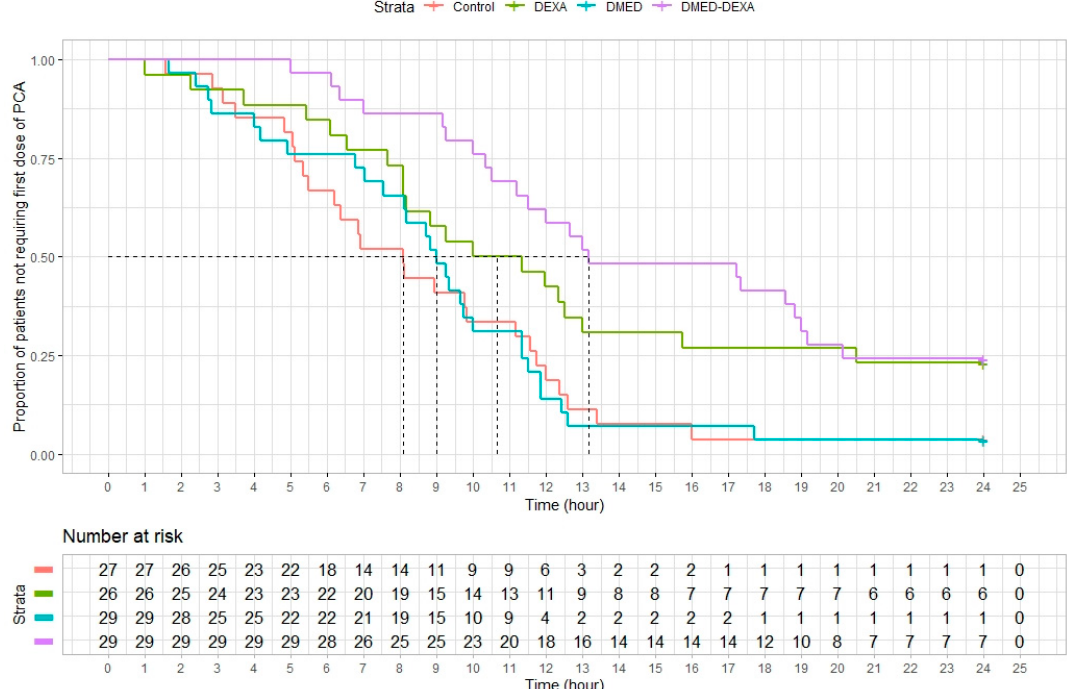
Figure 3. Survival analysis of the duration of analgesia. PCA, patient-controlled analgesia. The crossing points of the dotted and colored solid lines indicate median duration of the corresponding strata (groups). Median (IQR) times to first request for analgesia differed significantly among the Control (8.1 [6.2 to 11.6] hours), DMED (9.0 [8.1 to 11.3] hours); DEXA (10.7 [8.1 to 20.5] hours), and DMED-DEXA (13.2 [11.5 to 19.1] hours) groups ( p < 0.001) .